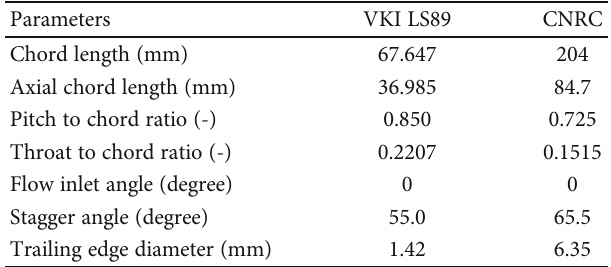
Table 1: Characteristic dimensions of research objects [15,